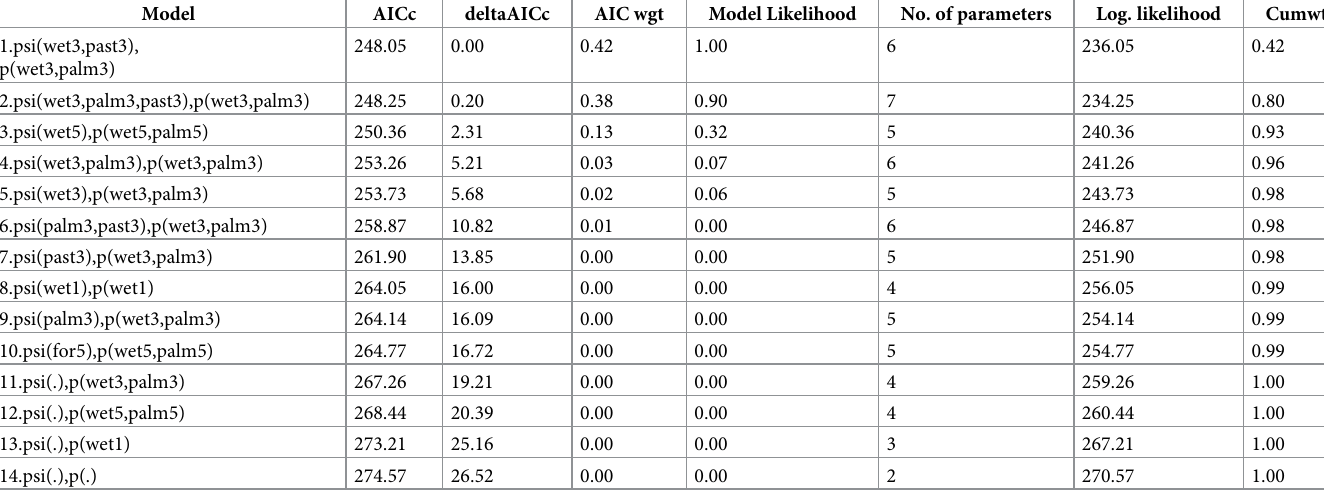
� Site and sampling covariates: wet1 = percentage of wetland coverage in 1 km buffers around each camera trap, wet3 = percentage of wetland coverage in 3 km buffers around each camera trap, palm3 = percentages of oil palm coverage in 3 km buffers around each camera trap, for5 = percentage of forest cover in 5 km buffers around each camera